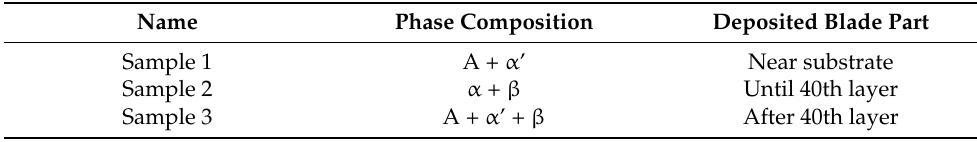
Table 3. Samples for testing selected heat treatment mode.